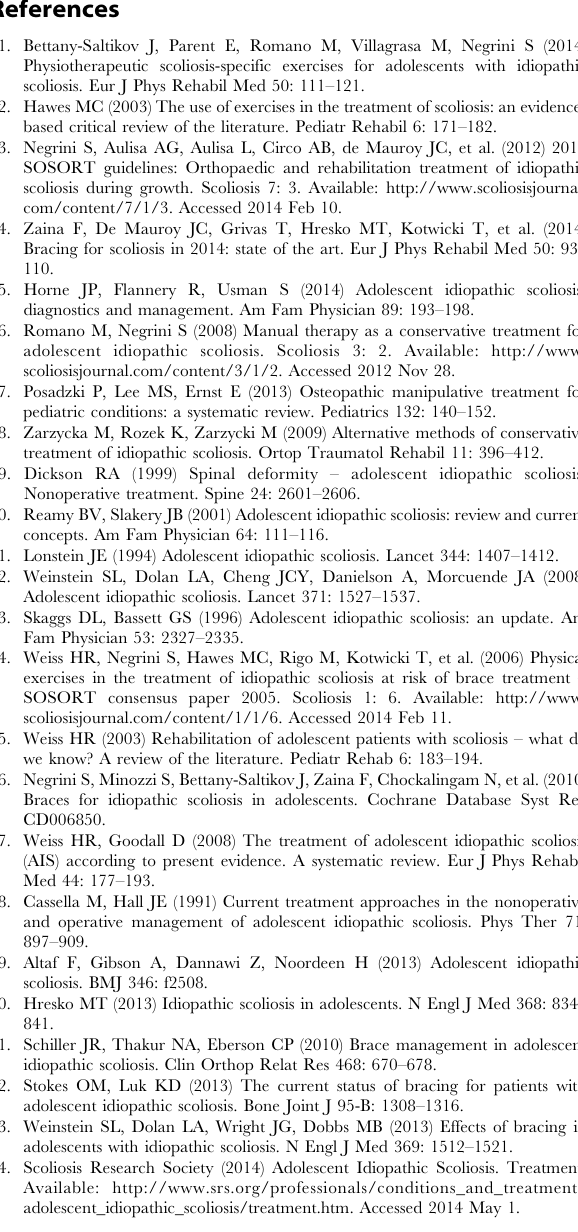
Table S1 List of included reviews. Table S2 List of excluded papers. Table S3 Details of the electronic search and selection